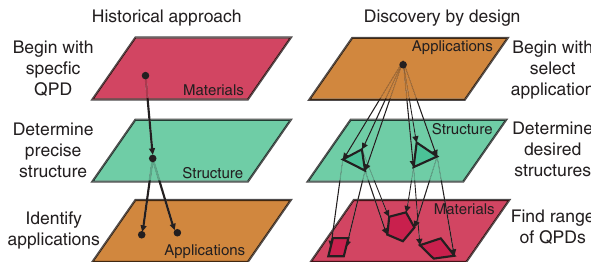
Figure 2: An efficient approach to QPD discovery would invert the existing paradigm (left) to identify materials and defects optimized for specific applications in quantum science